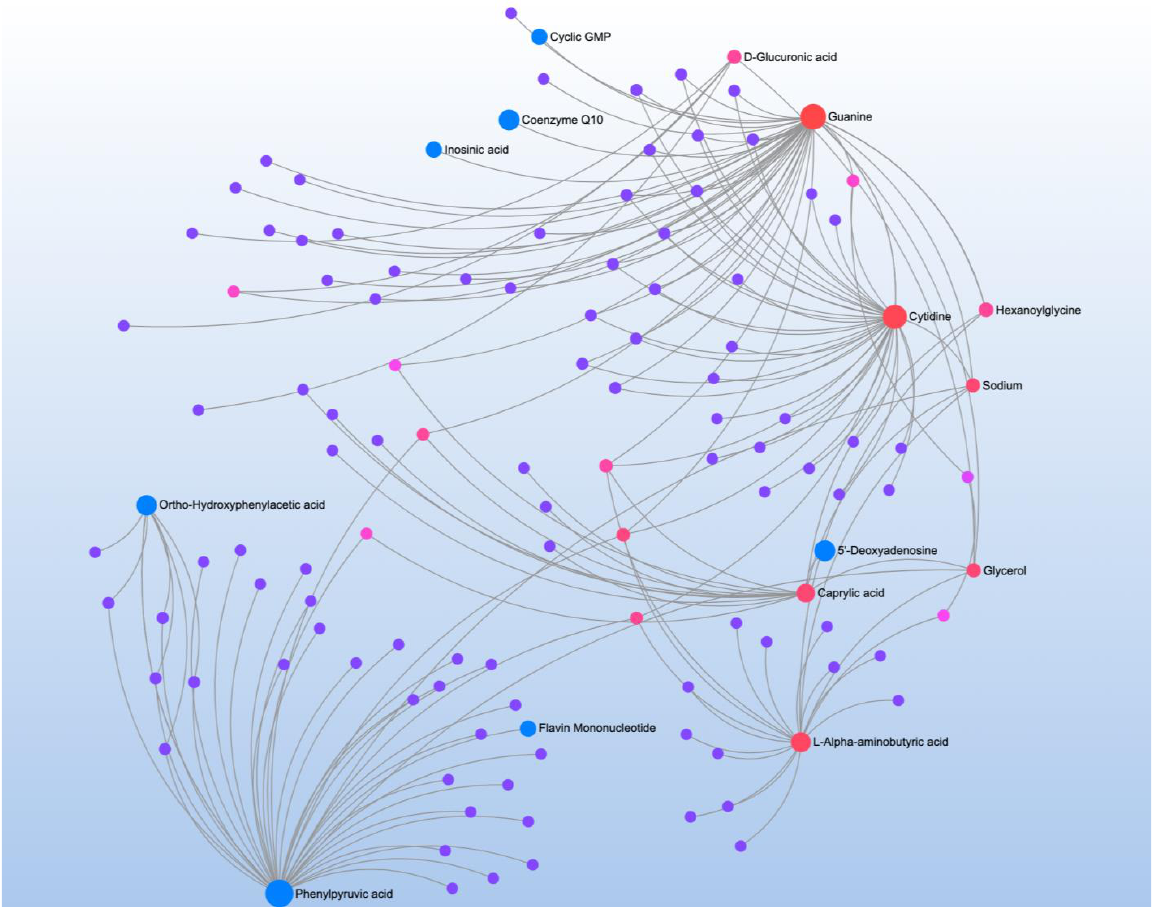
Figure 7. Metabolite-metabolite interaction network for significant metabolites that correlate with aberrant behavior. Size of the node indicates importance in the network. The interaction analysis highlights the importance of nucleotide metabolism as well as phenylalanine metabolism.